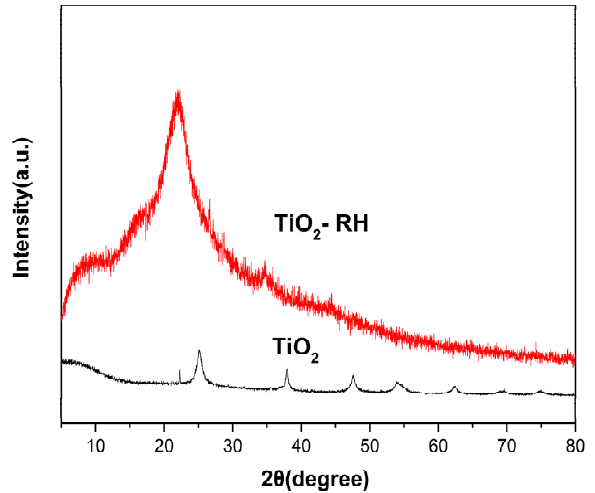
Figure 1. XRD patterns of TiO 2 and TiO 2 -RH.